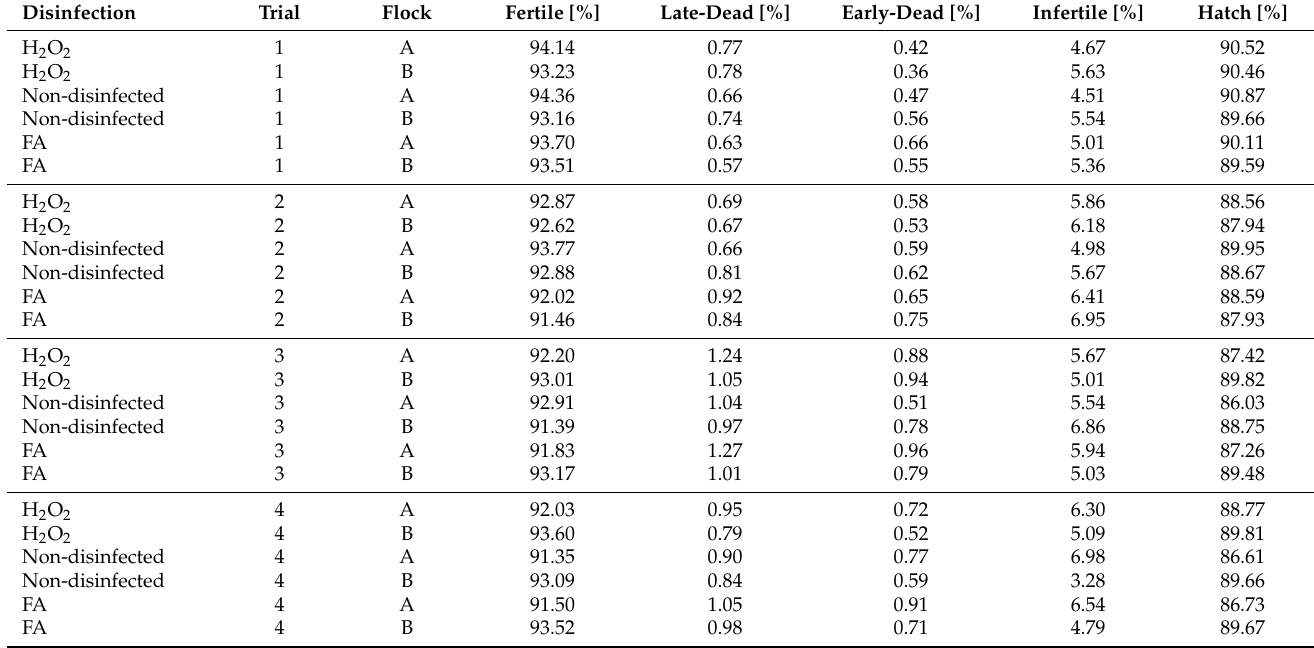
Table 1. Results from the hatchery. Presentation of the number of fertile eggs (Fertile), early (Early- dead) and late dead embryos (Late-dead) and infertile eggs (Infertile) detected via candling, as well as the hatching rate (Hatch) for trials 1 to